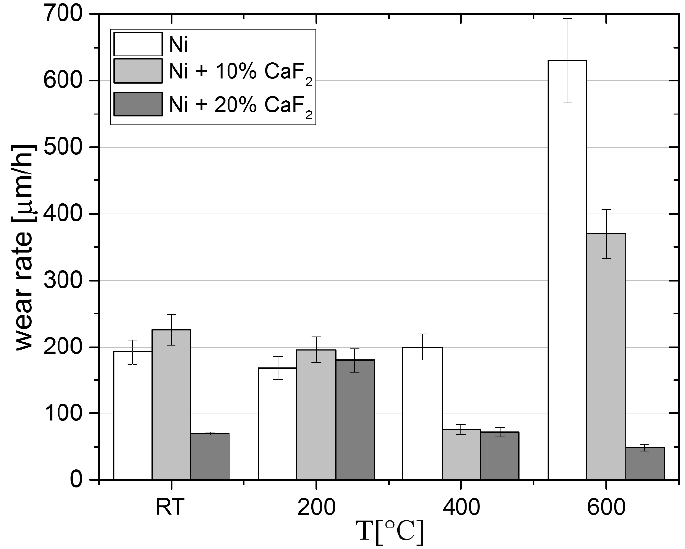
Figure 2. Wear rates at investigated temperature for sintered pure Ni, Ni-10% CaF 2 and Ni-20% CaF 2 self-lubricating composites. Results for pure Ni and for 20% addition of CaF 2 were taken from previous work [43] and added for data clarity.